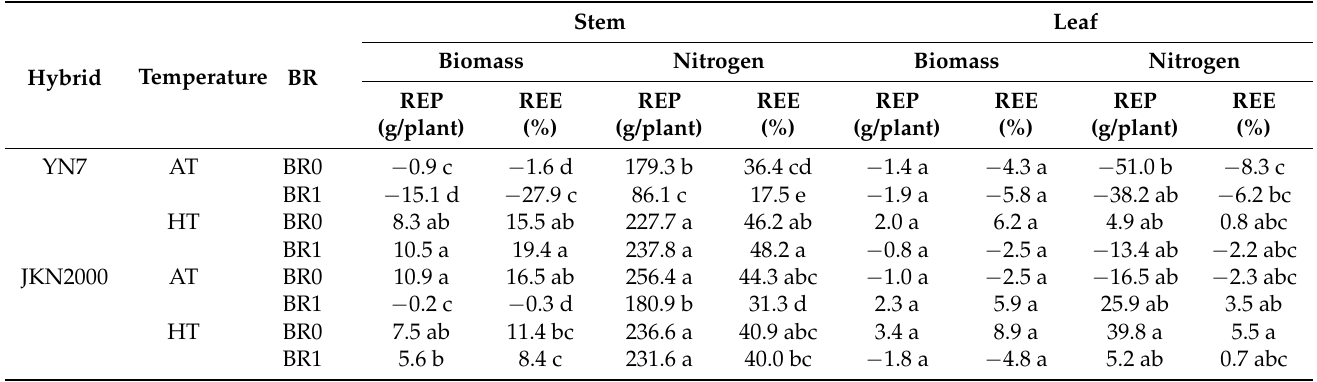
Table 1. Effects of BR application at the silking stage on the nutrient translocation in the stem under post-silking ambient and high